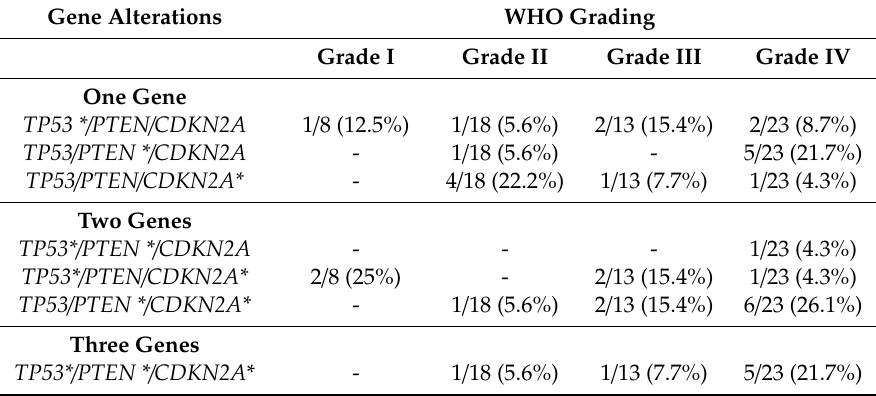
Table 6. Frequency of single and concurrent TP53 , PTEN, and CDKN2A alteration by WHO grade of